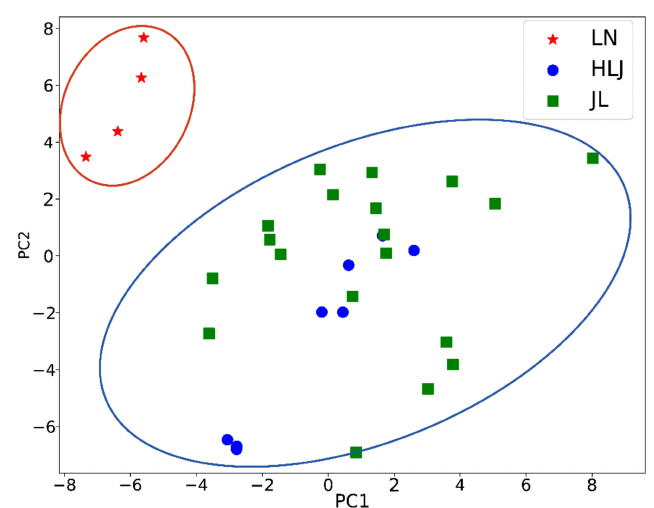
Figure 3. The PLS-DA results of ginsengs from three geographical